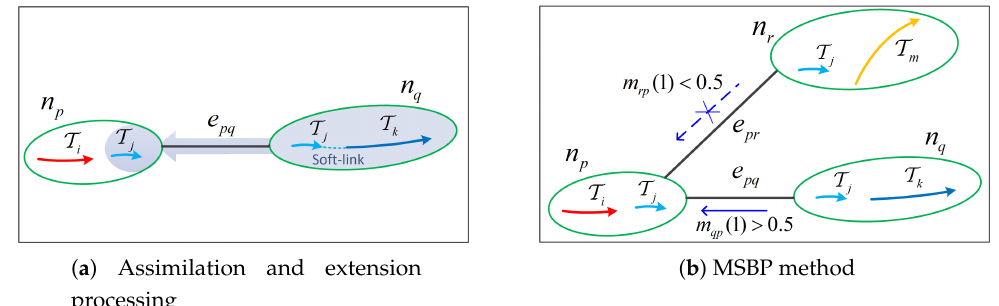
Figure 6. Diagram of assimilation, extension processing, and the MSBP method: ( a ) The soft link and assimilation in the right node, where the assimilation extends to the left node through T j . Panel ( b ) demonstrates that the left node n p accepts the message passed by the right node n q and does not adopt the message passed by node n r